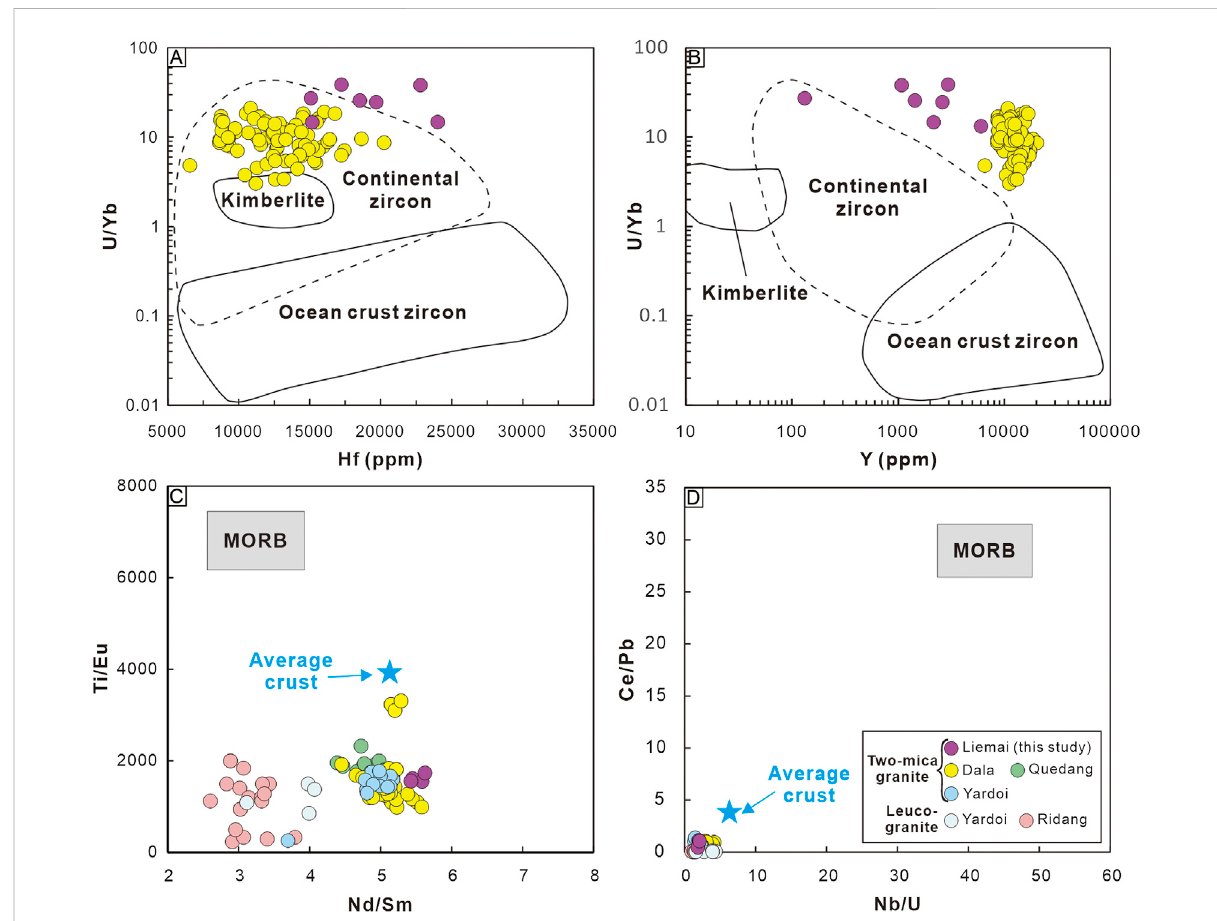
FIGURE 8 (A) U/Yb vs. Hf and (B) U/Yb vs. Y diagrams of zircons from the Liemai two-mica granite (Grimes et al., 2007); (C) Ti/Eu vs. Nd/Sm and Ce/Pb vs. Nb/U diagrams for the Liemai two-mica granite. The fi elds of MORB (mid-ocean-ridge basalt) and average crust are from Klein (2003) and Rudnick and Gao (2003), respectively. The granites and leucogranites are the same as in Figure